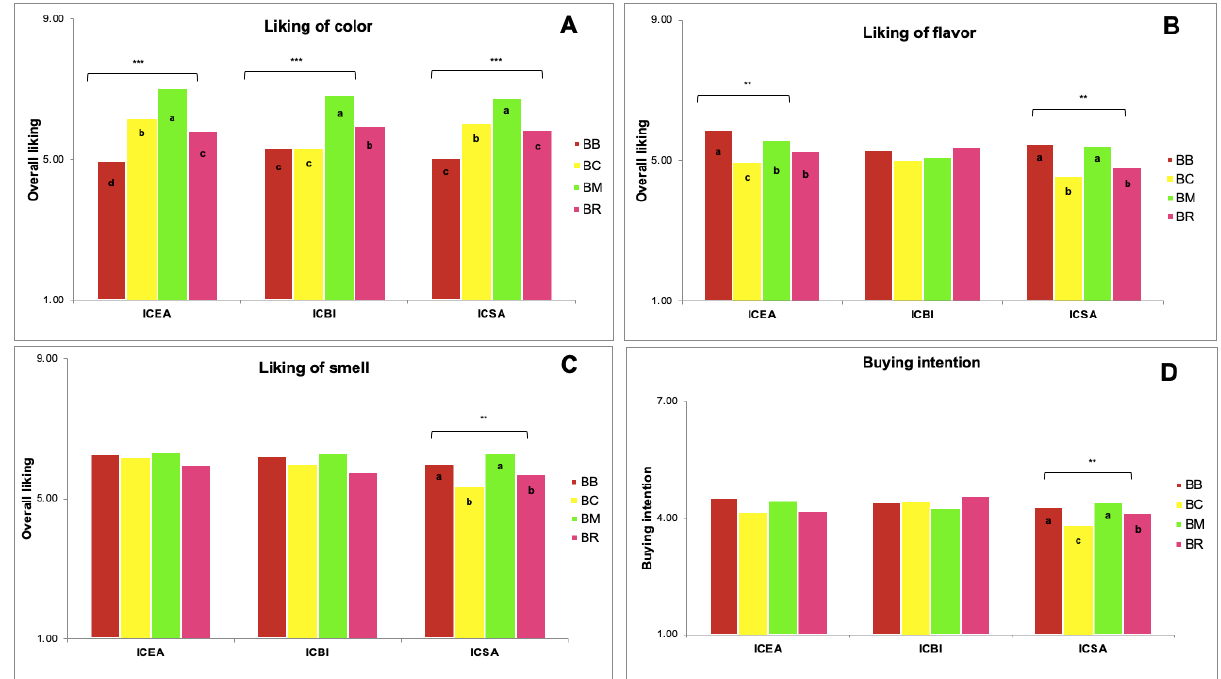
Figure 2. Mean (n = 400) of hedonic grades for the liking degree ( A : color, B : flavor, C : smell) and buying intention ( D ) of the developed beverages according to the school of origin of the participants: Basic Sciences and Engineering (ICBI), Commerce and Business Administration (ICEA) and Health Sciences (ICSA). Different lowercase letters between bars indicate significant difference (*** p < 0.001 and ** p < 0.01).